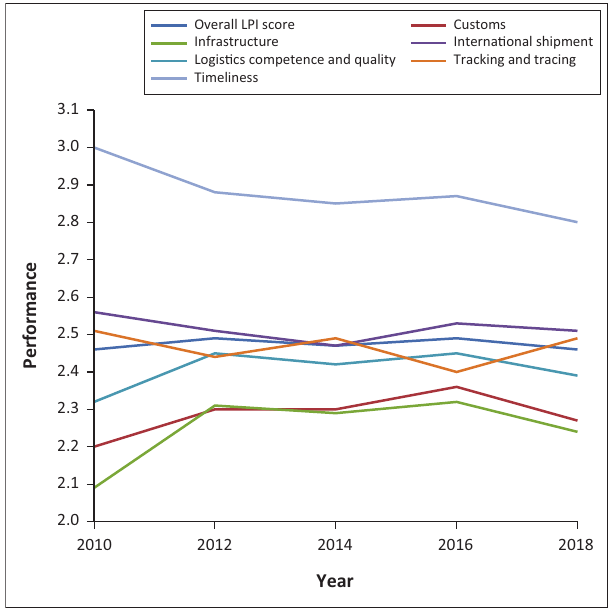
FIGURE 4: Logistics performance of Africa in Logistics Performance Index six components.